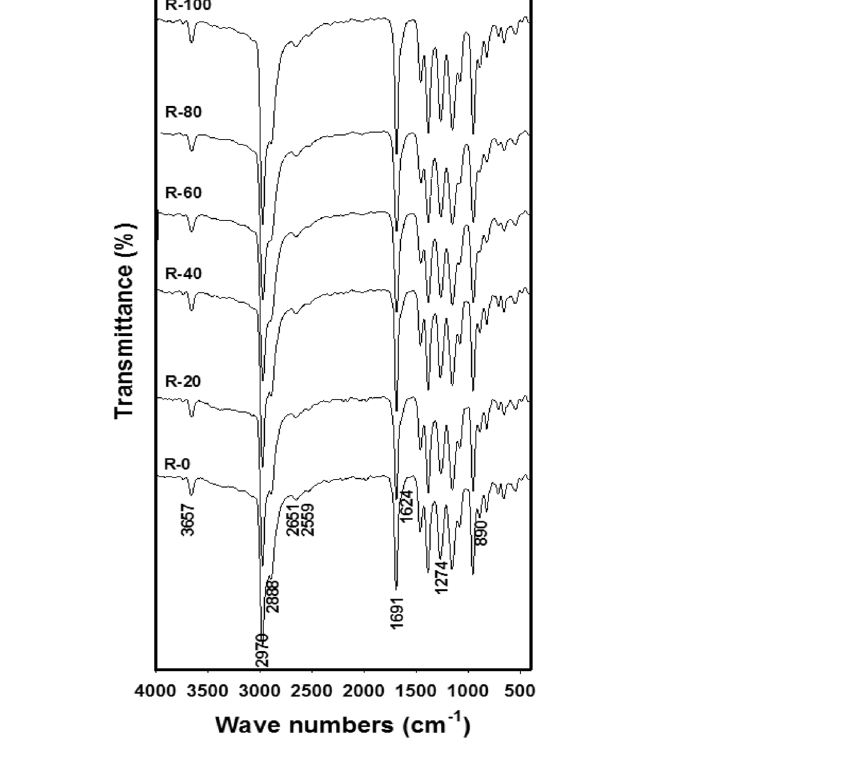
Figure 1. FTIR spectra of R-0, R-20, R-40, R-60, R-80, and R-100 samples at different irradiation doses and a fixed dose rate of ~ 0.9